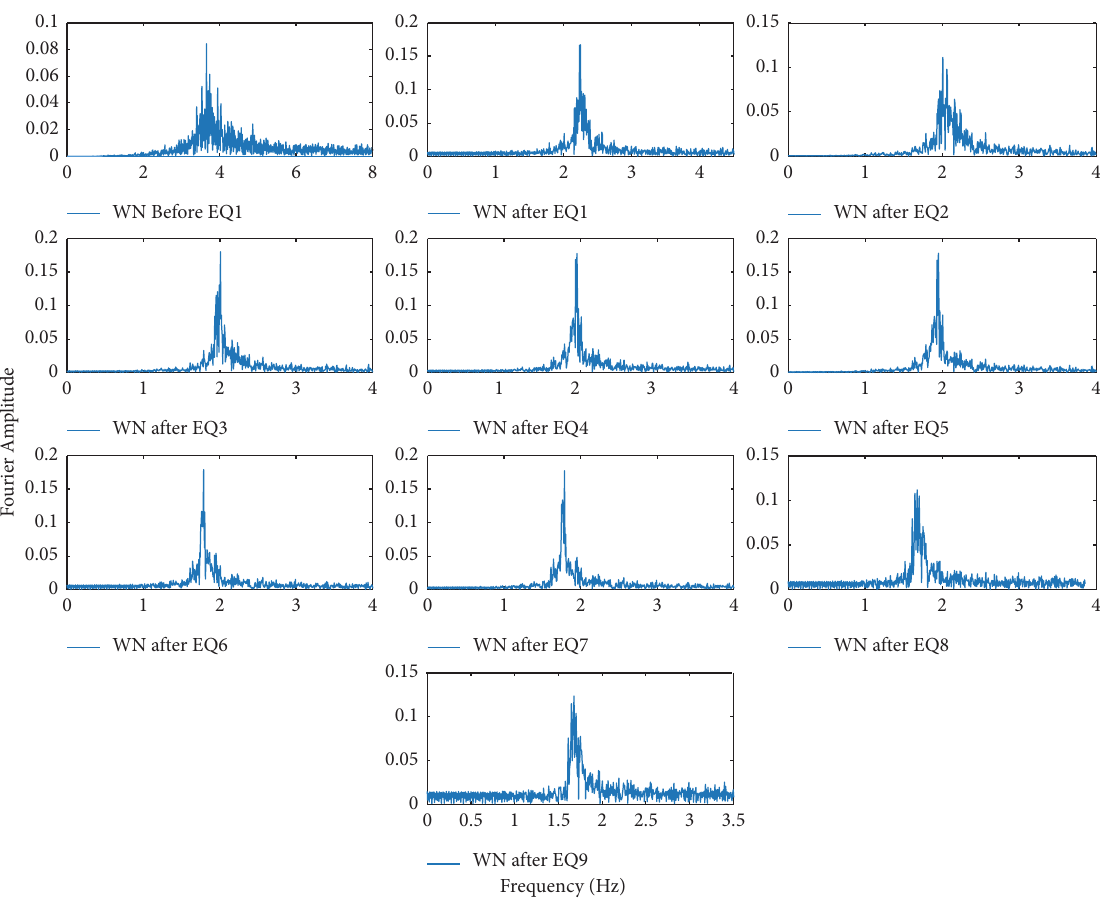
Figure 9: Fourier spectrum before and after each record.